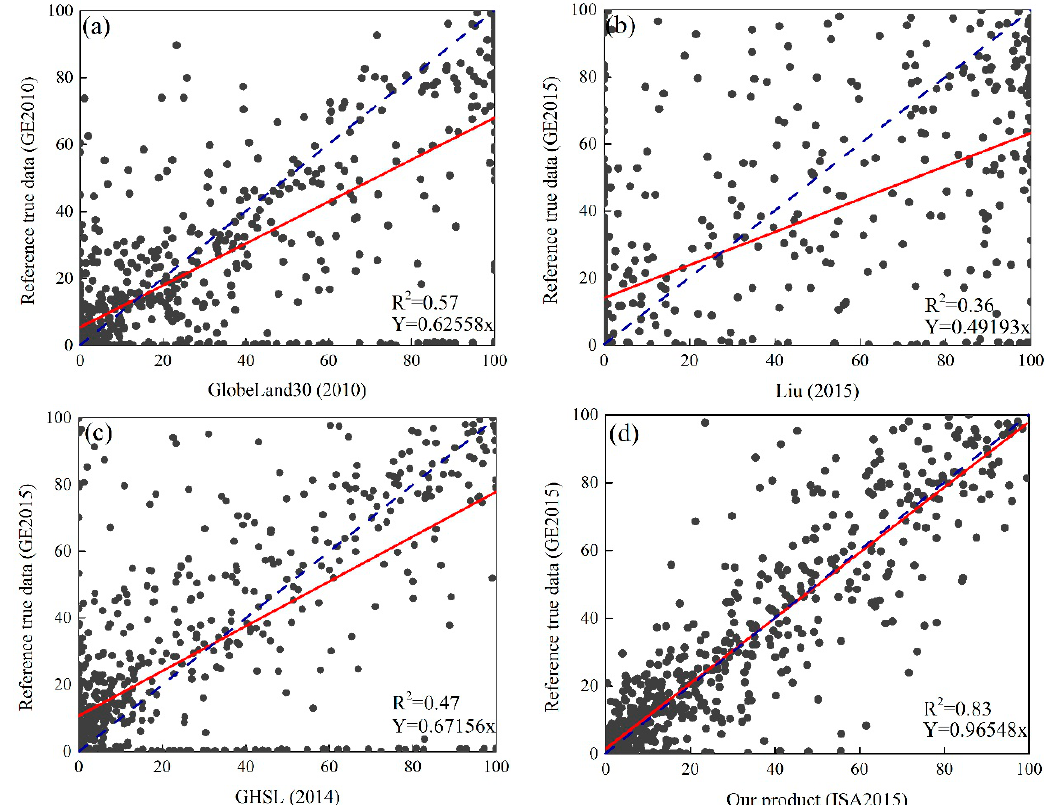
Figure 16. Scatter plot of 735 blocks, in which each plot represents estimated urban area percentage against the referenced urban area percentage in ( a ) GlobeLand30, ( b ) Liu’s product, ( c ) GHSL and ( d ) Our product.